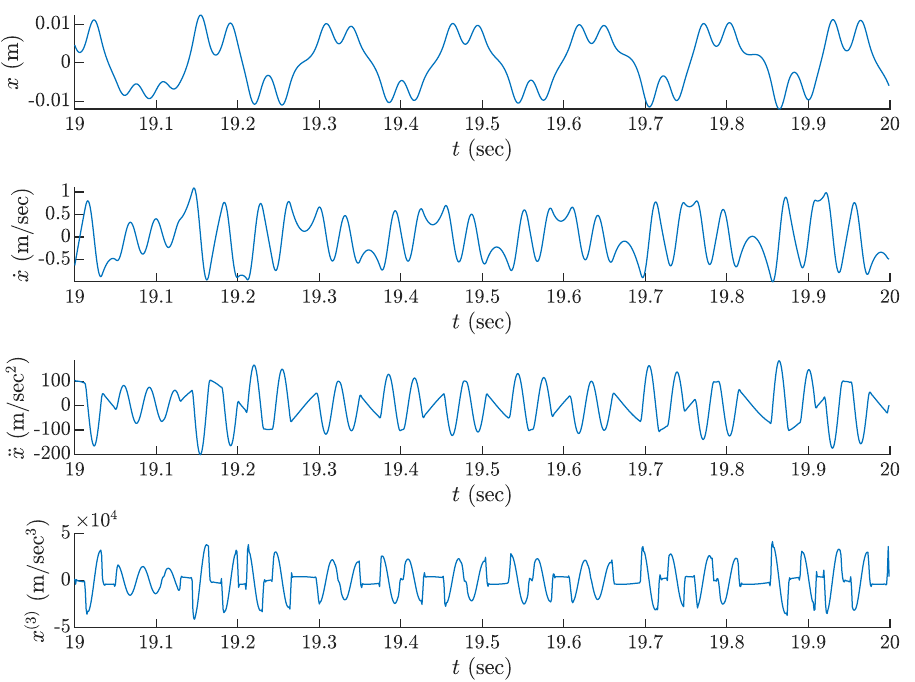
Figure 4. Time series for the Lin-Ewins chaotic